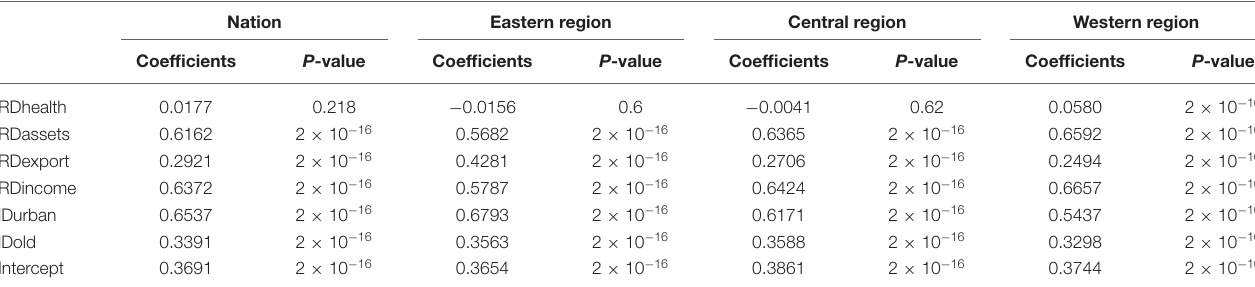
TABLE 4 | Estimation results of linear part.